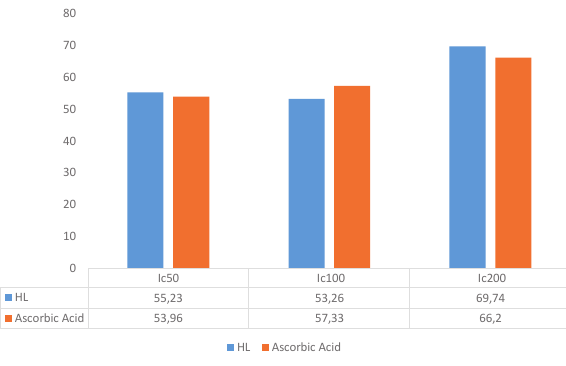
Table 6: Free binding energy of complexes and ligand.